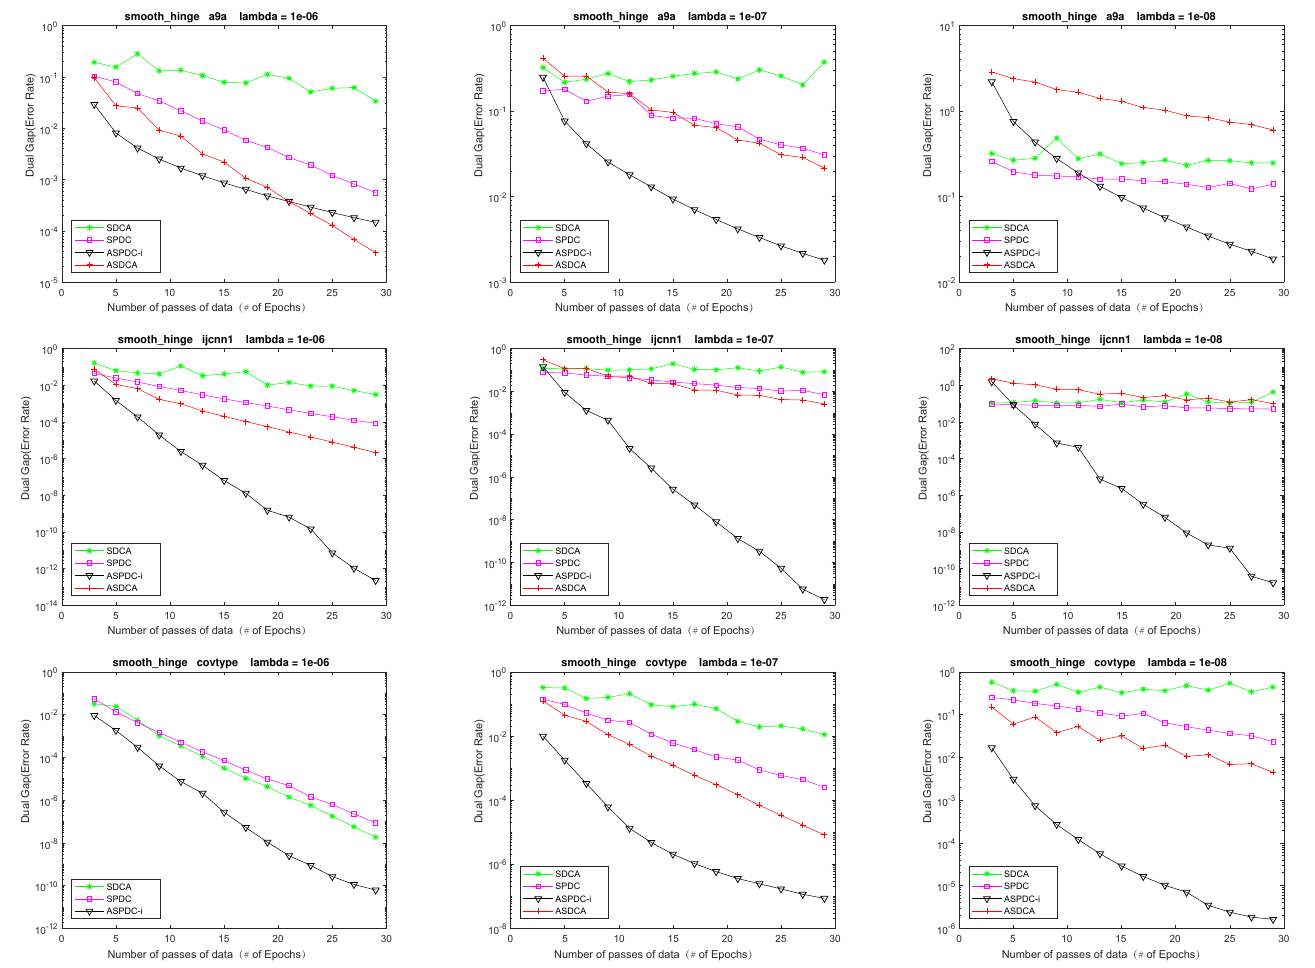
Figure 2. Dual-gap ( y -axis) vs. the number of epochs ( x -axis). Comparing ASPDC-i with other methods for smooth hinge SVM on real-world datasets with regularization coefficient λ ∈ { 10 − 6 ,10 − 7 ,10 − 8 } . The horizontal axis is the number of passes through the entire dataset, and the vertical axis is the logarithmic